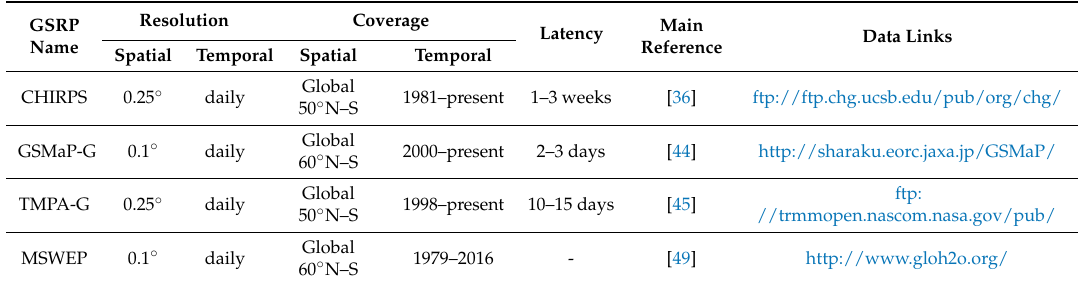
Table 2. Salient features of the GSRPs used in the study for the period of 2009–2016.